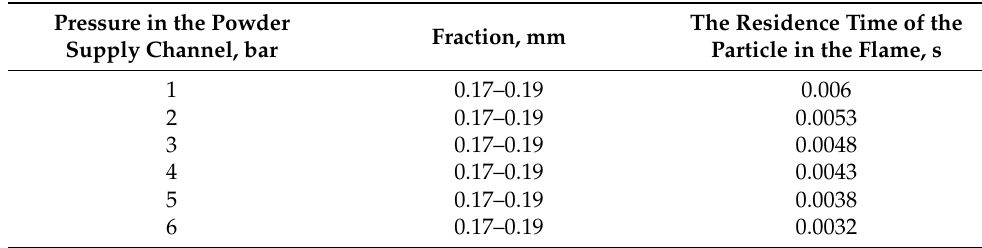
Table 3. Relationship of the pressure of the transporting gas and the residence time of the particle in the body of the torch.